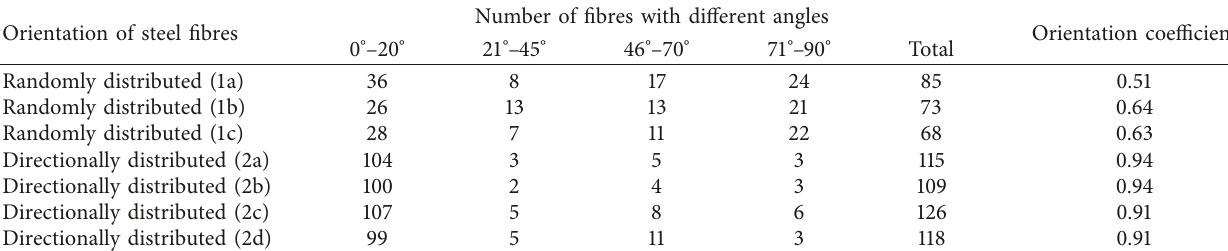
Table 2: The angle statistics of the steel